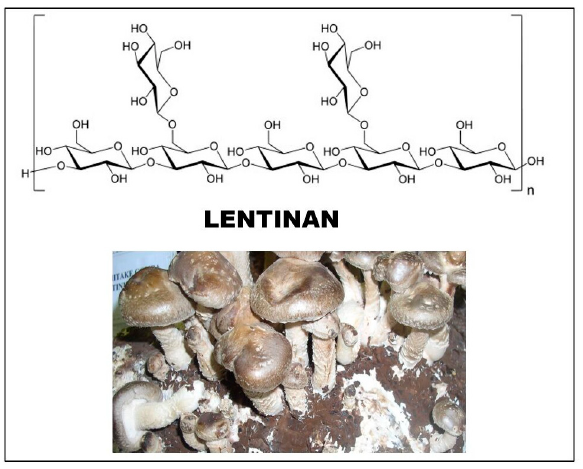
Figure 3. Structure of lentinan, the main glucan of Lentinula edodes (shiitake). The molecular weight of the glucan fractions from shiitake—according to recent data—varies between 300 and 800 kDa, with an average of 500 kDa. The configuration of the molecule is as follows: in aqueous solution, the H-bridges form a triple helix structure, while the configuration is a random coil when dissolved in DMSO